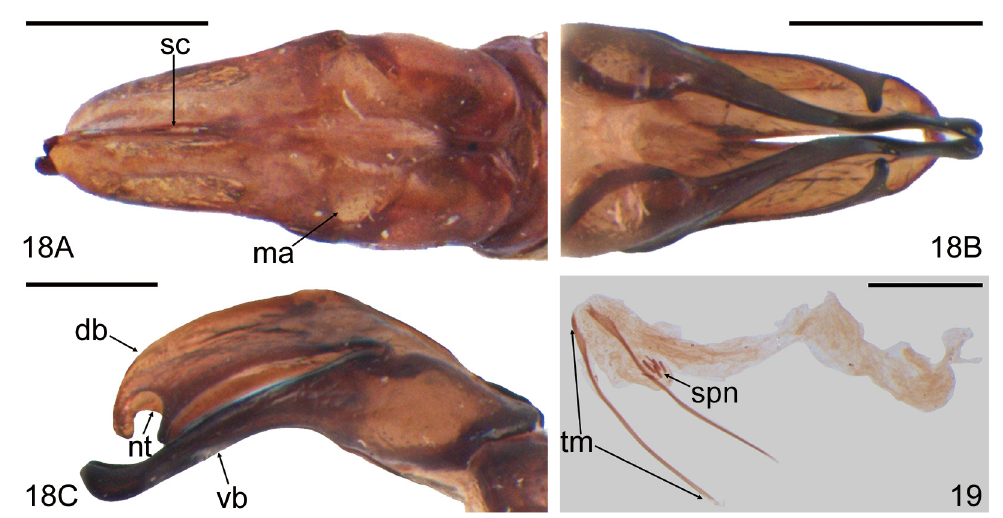
Figs 18–19. Morphotype VII “ Rugaticollis ”. Male genitalia of M. rugaticollis (Moser, 1913), lectotype (MFNB). 18 . Parameres in dorsal (A), ventral (B) and lateral (C) views. 19 . Endophallus and temones in lateral view. Scale bars = 1.0